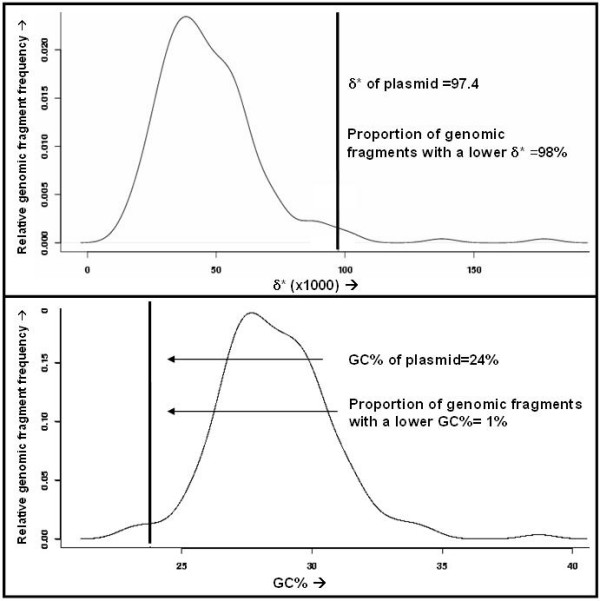
Comparison of the δ* value and the GC content of plasmid lp5 with the δ* value and the GC content of the genome of B. burgdorferi B31. The chromosome sequence (here B. burgdorferi B31) is divided in non-overlapping fragments with a size equal to the length of the input plasmid sequence (the Borrelia plasmid lp5, NC_000957), after which a frequency distribution is made for both δ* and the GC percentage scores. The δ* value of the input plasmid sequence is plotted vertically in the fragment distribution, indicating the proportion of genomic fragments with a lower δ* value. Consequently, this analysis can be performed for the GC content. The value of the plasmid GC content plotted in the fragment distribution indicates the proportion of genomic fragments with a lower GC percentage.